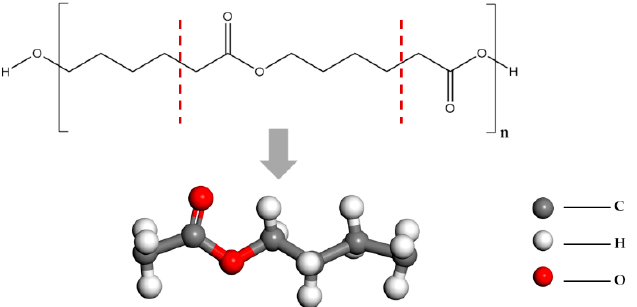
Figure 1. Structure of PCL and the fragments selected in this study.